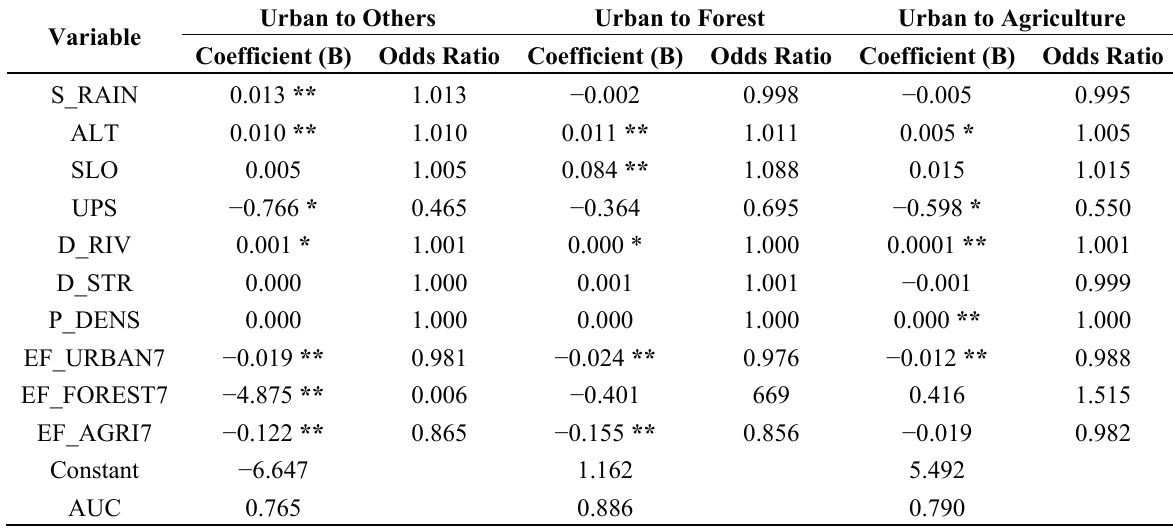
Table 3. Factors of urban land-use changes using logistic regression (1980~1990). Urban to Others Urban to Forest Urban to Agriculture Variable